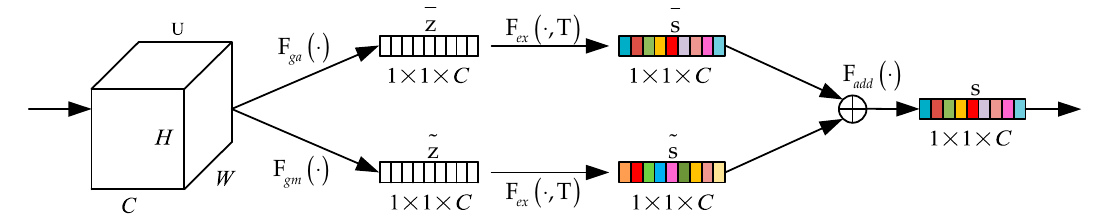
Figure 2. The structure of the average and max channel (AMC) attention building block.